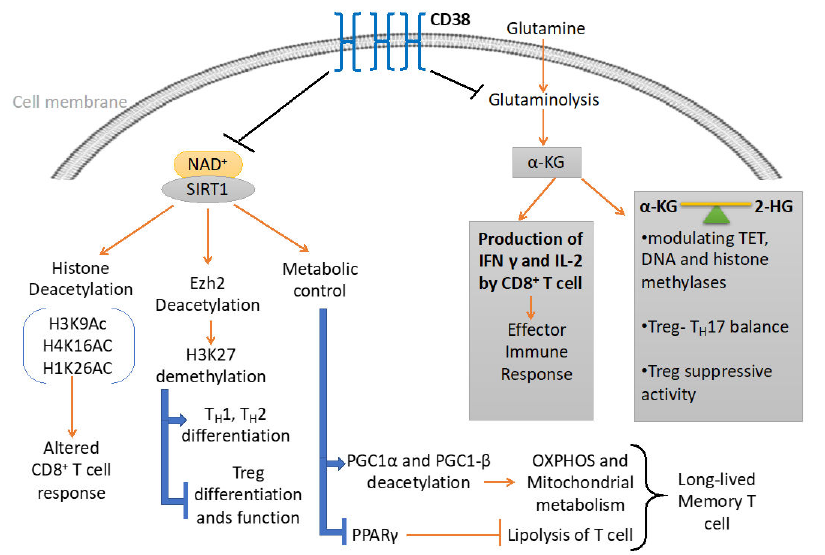
Figure 2. CD38 mediated regulation of metabolic pathways and chromatin modifications in T cells. CD38 a ff ects the di ff erentiation and e ff ector response of T cells through modulating the metabolic pathways and epigenetic landscape of T cells. On one hand, CD38 curtails the availability of NAD + to Sirt1 and hence attenuates its enzymatic activity which regulates di ff erent metabolic and epigenetic pathways in T cells. On the other hand, CD38 inversely regulates glutaminolysis pathways, which not only regulate e ff ector cytokine production in T cells but also produce α -ketoglutarate ( α -KG) and 2-hydroxyglutarate (2-HG), important epigenetic